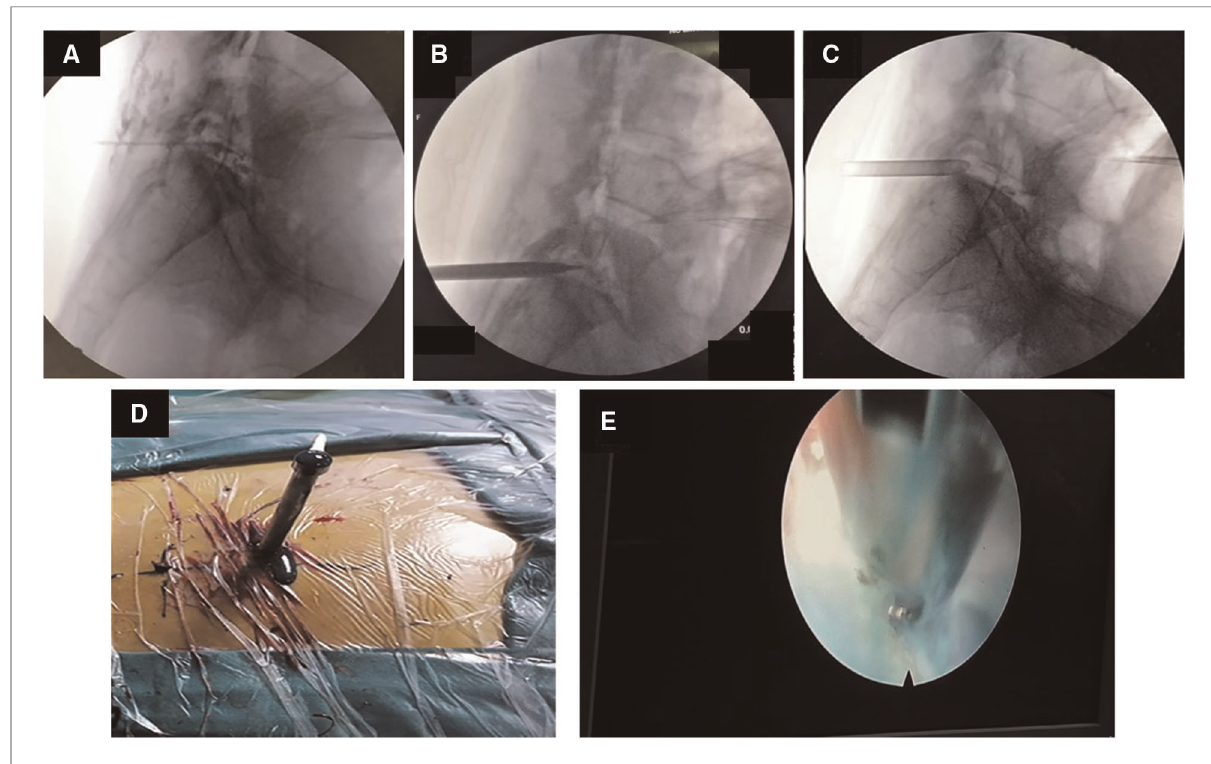
FIGURE 4 Images and video during percutaneous endoscopic drainage. ( A ) The guide wire is positioned at L5/S1. ( B ) Insert the channel along the guide wire. ( C ) The channel is placed at L5/S1. ( D ) After the passage is placed, pus begins to fl ow out. ( E ) Microscopic video of massive pus